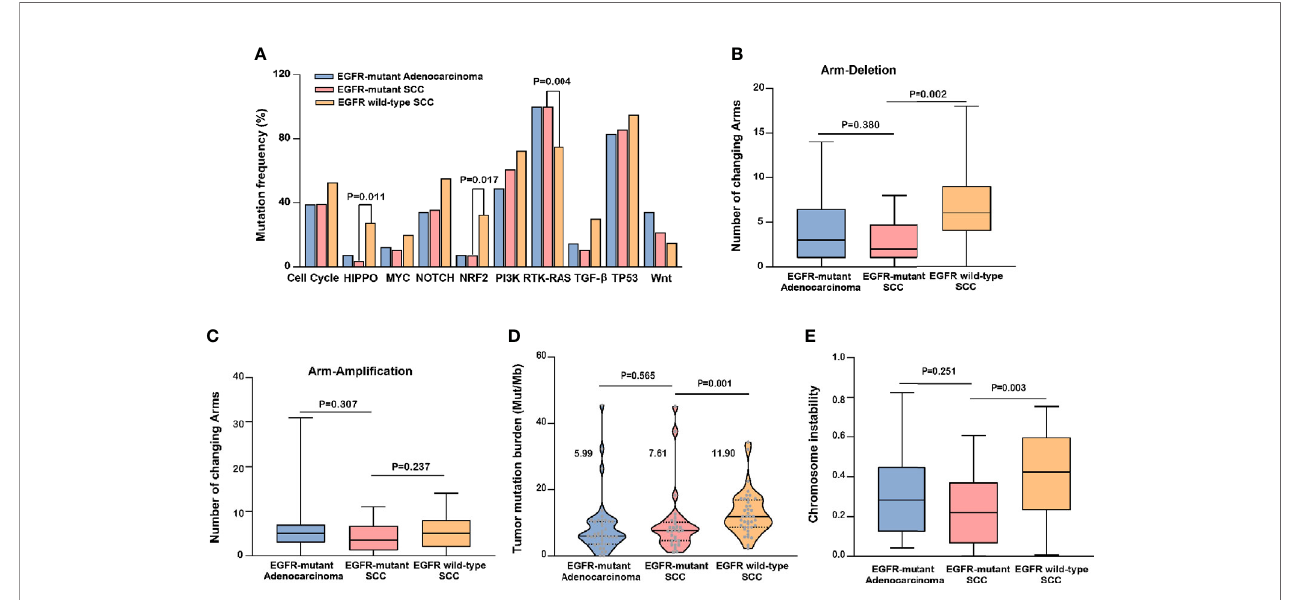
FIGURE 3 | Comparison of genomic pro fi les among EGFR -mutant adenocarcinoma, EGFR -mutant squamous cell carcinoma (SCC), and EGFR wild-type SCC. Comparison of 10 signaling pathway mutation frequency (A) , change number of arm deletion (B) and arm ampli fi cation (C) , tumor mutation burden (TMB) (D) , and chromosome instability (CIS) (E) among three subsets were